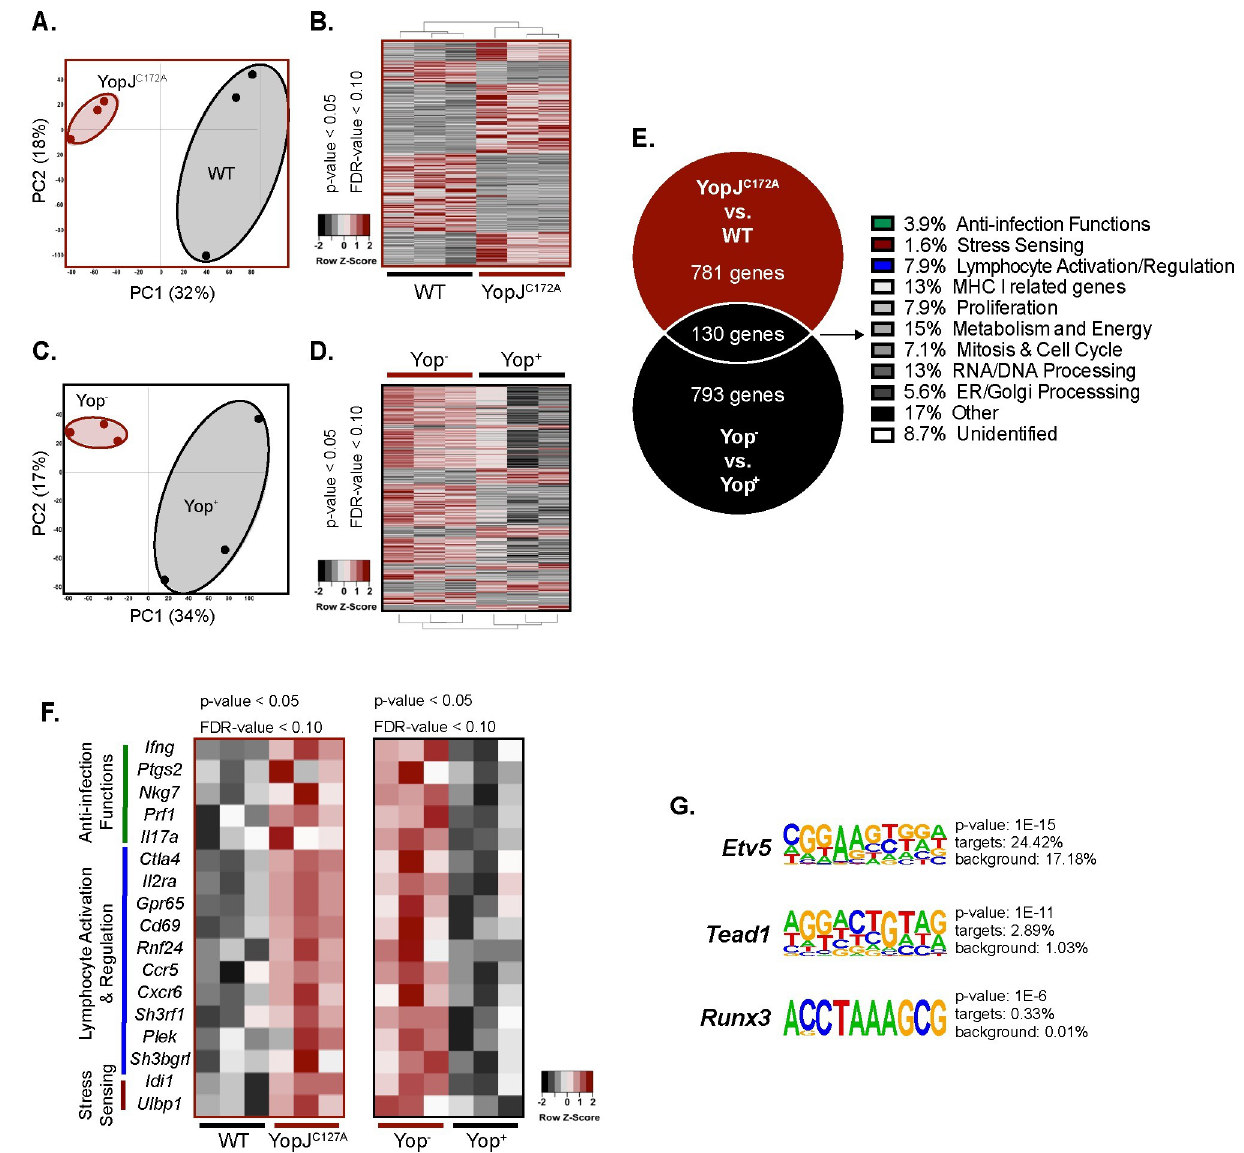
Fig 4. YopJ translocation leads to the inhibition of a broad anti-microbial gene response from V γ 4 T cells. ( A and B ) MLN suspensions from L . monocytogenes infected mice were stimulated with 10 MOI of WT or YopJ C172A Y . pseudotuberculosis for 24 hours. Antibiotics were given 2 hours post- stimulation. Five hundred V γ 1.1/2 - CD44 hi CD27 - γδ T cells from each stimulation were flow sorted and processed for RNA sequencing. ( A ) PCA plots are depicted for similarity of groups YopJ C172A and WT Y . pseudotuberculosis stimulated V γ 1.1/2 - CD44 hi CD27 - γδ T cells. ( B ) Heat maps are depicted for differentially expressed genes of YopJ C172A or WT Y . pseudotuberculosis stimulated V γ 1.1/2 - CD44 hi CD27 - γδ T cells. ( C and D ) MLN suspension from L . monocytogenes infected mice were stimulated with 1 MOI of WT Yptb - β la. Five hundred Yop + or Yop - V γ 1.1/2 - CD44 hi CD27 - γδ T cells were flow sorted and processed for RNA sequencing. ( C ) PCA plots are depicted for similarity of Yop + or Yop - V γ 1.1/2 - CD44 hi CD27 - γδ T cells. ( D ) Heat maps are depicted for differentially expressed genes of Yop - or Yop + stimulated V γ 1.1/2 - CD44 hi CD27 - γδ T cells. ( E - G )A Venn diagram of differentially expressed genes (higher) that overlapped between RNA sequencing analyses favoring YopJ C172A Y . pseudotuberculosis stimulation or Yop - cells is displayed. Shared genes were categorized by gene function. ( F ) The heat map highlights differentially expressed genes among V γ 1.1/2 - CD44 hi CD27 - γδ T cells from the indicated stimulations and categories. ( G ) Homer motif analysis was performed on the RNA sequencing dataset. Motifs and associated genes to YopJ C172A stimulated V γ 1.1/2 - CD44 hi CD27 - γδ T cells are highlighted. Each experiment was performed with 3 biologic samples per group. Cutoffs for significant genes are p < 0.05 and FDR <